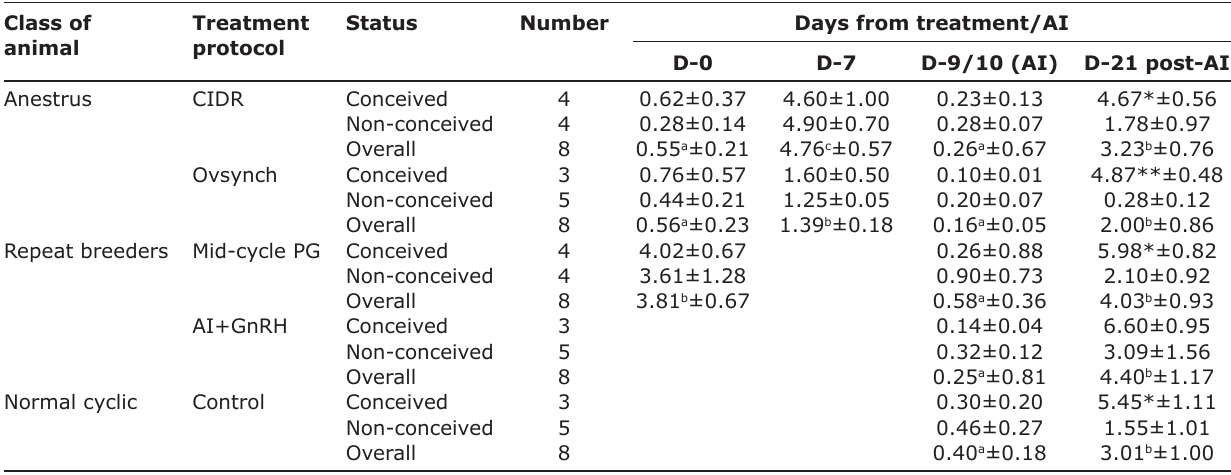
Table 1: Mean plasma progesterone concentrations (ng/ml) in anoestrus and repeat breeding buffaloes on different days of treatment and AI under various treatment protocols and in normal cyclic control group. Class of